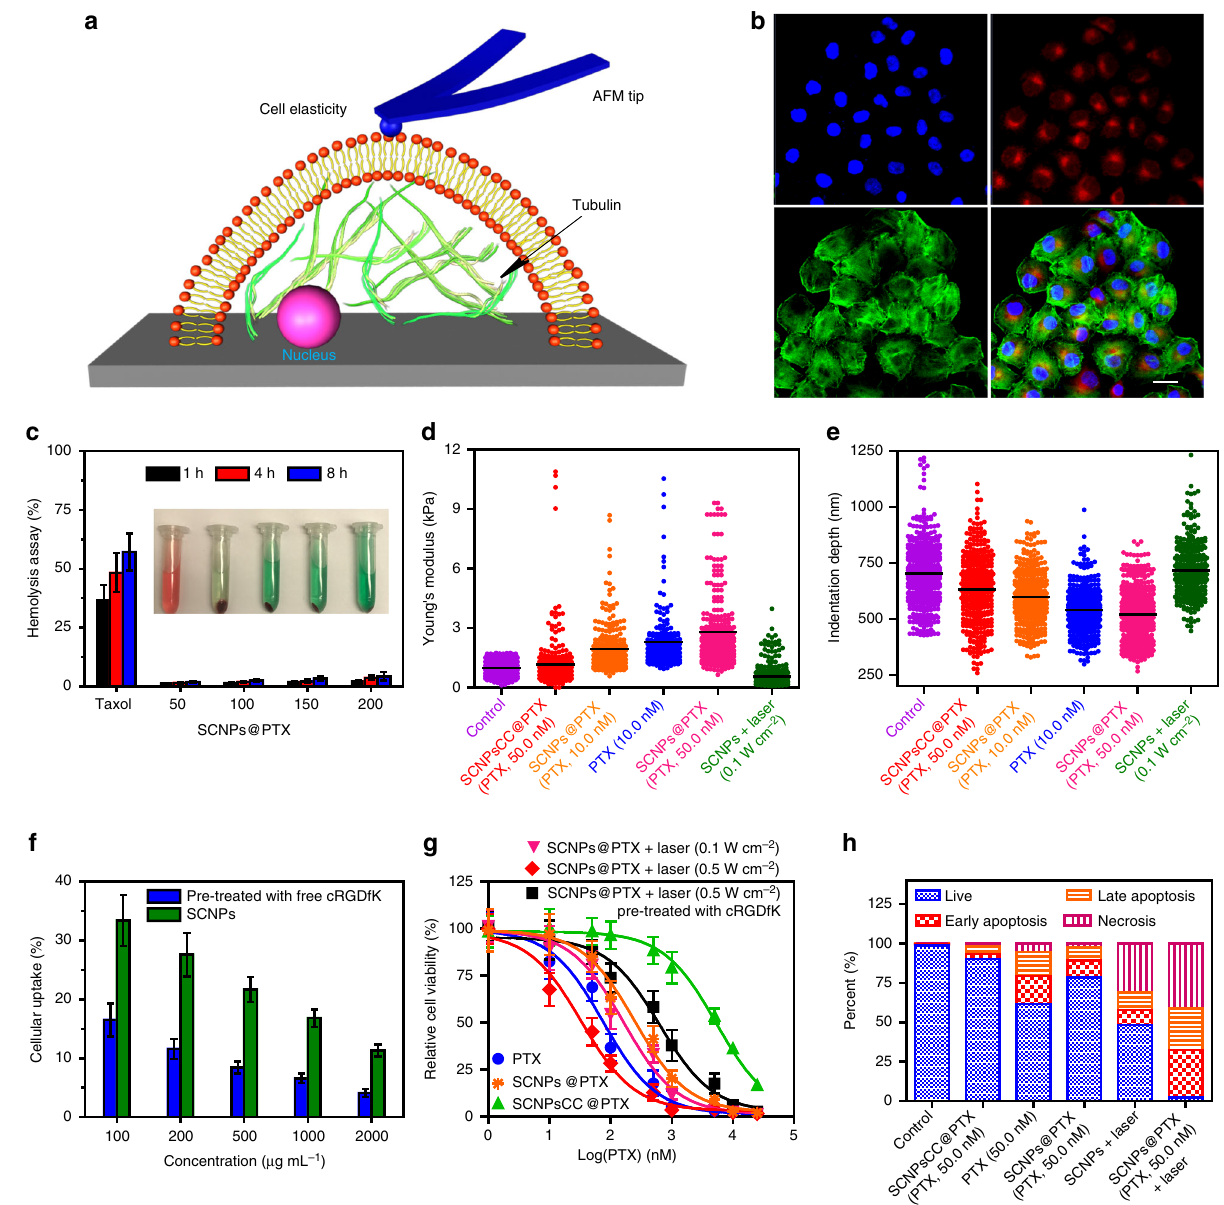
Fig. 5 In vitro thermo-chemotherapy. a Schematic of AFM method used in the measurements of cell mechanical properties. b CLSM images of the HeLa cells cultured with Cy5.5-labelled SCNPs@PTX. Blue fl uorescence shows nuclear staining with Hoechst 33342; red fl uorescence shows the location of Cy5.5-labelled SCNPs@PTX; green fl uorescence shows β -actin staining with FITC-phalloidin. Scale bar is 20 μ m. c Haemolysis rates of PTX (50 μ g mL − 1 ) and SCNPs@PTX at various concentrations (50, 100, 150, and 200 μ g PTX mL − 1 ). Inset: the corresponding image of RBCs treated with PTX